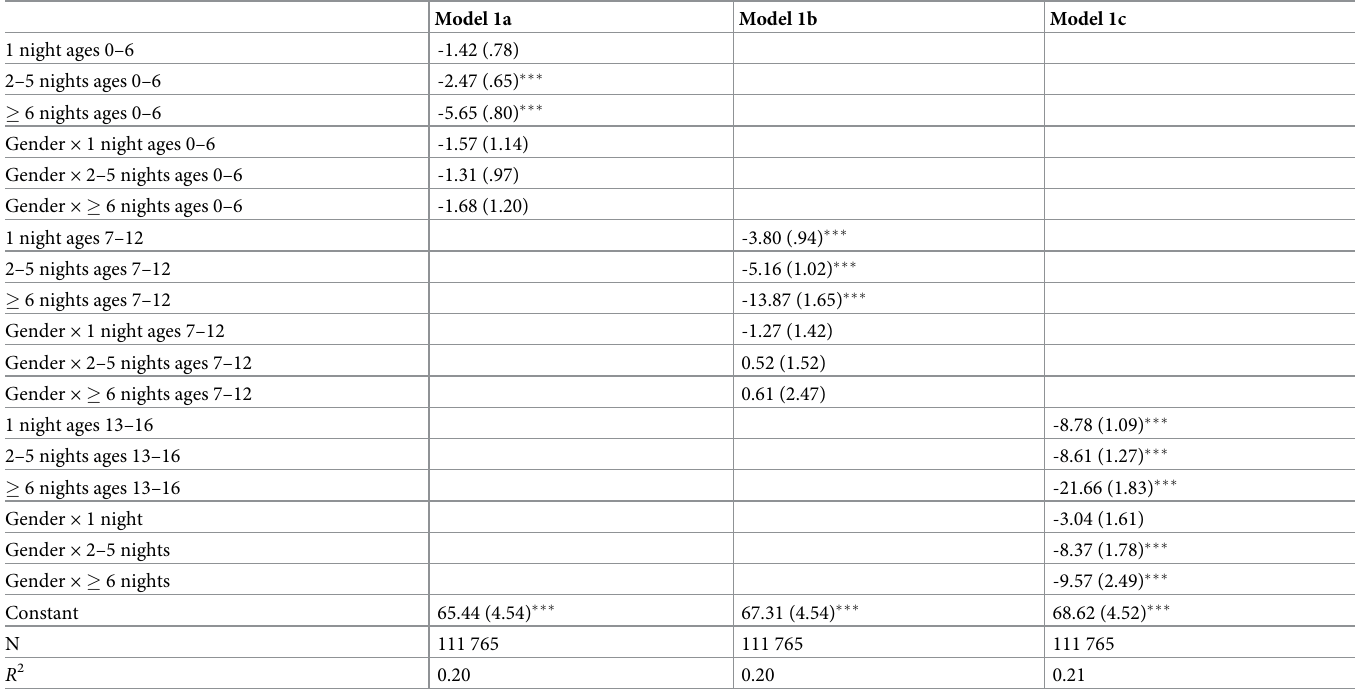
Table 3. Standardized beta-coefficients of overall grade points by hospitalization timing and gender interactions. Standard error in